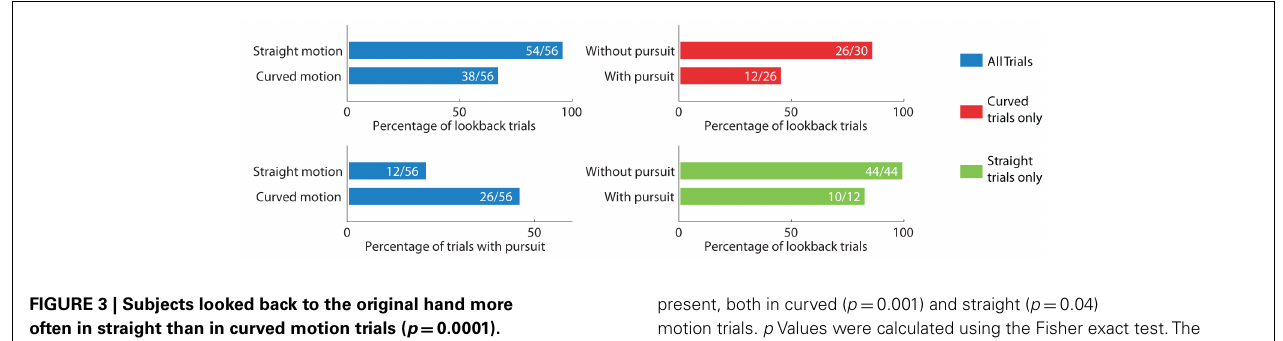
FIGURE 3 | Subjects looked back to the original hand more often in straight than in curved motion trials ( p = 0.0001). Smooth pursuit predominated in curved motion trials ( p = 0.009). Subjects ignored the original hand when smooth pursuit was